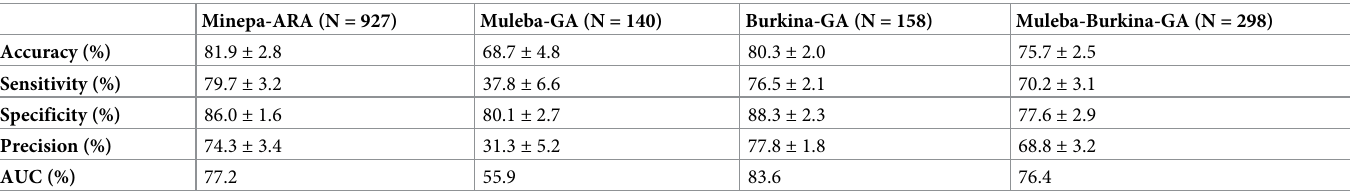
Table 2. Performance of an ANN model trained on 75% of mosquito spectra with 1851 features (before autoencoder) and tested on the remaining 25% spectra (out of the sample testing). AUC values are the area of the ROC curves in Fig 8. Minepa-ARA (Nulliparous = 656, Parous = 271), Muleba-GA (Nulliparous = 119, Parous = 21) Burkina-GA (Nulliparous = 80, Parous =